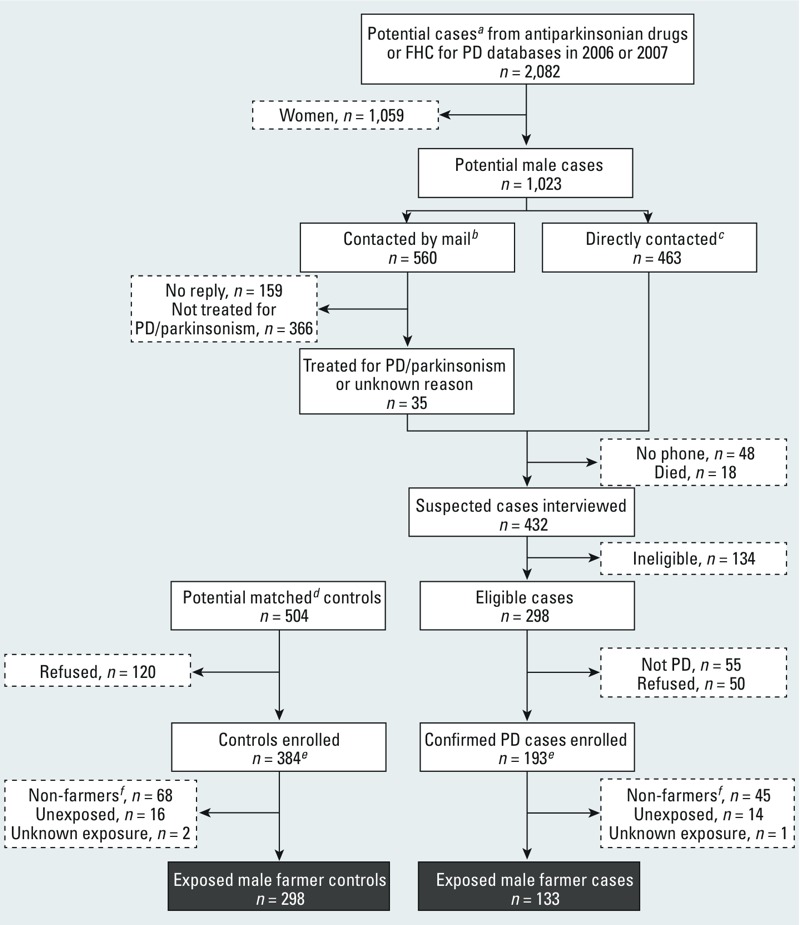
Flowchart for the inclusion of male farmer cases and controls in the study.
aPersons < 80 years of age and without free health care (FHC) for dementia or psychiatric conditions. bPersons with at least one prescription of piribedil, amantadine, or anticholinergics who did not use other antiparkinsonian drugs. cPersons with at least one delivery of levodopa, entacapone, tolcapone, ropinirole, pramipexole, apomorphine, bromocriptine, or selegiline. dMatching for age (± 2 years), sex, and district. e191 triplets (1 case and 2 controls) and 2 pairs (1 case and 1 control). fNon-farmers included workers in food and beverage processors; clerical supervisors, including bookkeepers, cashiers, and related workers; and life scientists and related technicians.